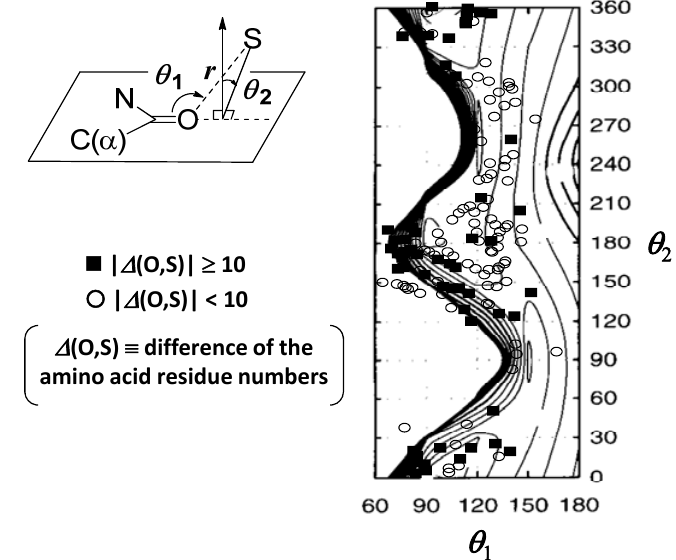
Figure 6. The directionality around the O atom in the S–S···O=C interactions in proteins superimposed on the potential surface calculated for the complex of between CH and CH CONHCH at MP2/6-31G(d). The contour lines are drawn with an interval of 3 3 0.25 kcal/mol. This figure was modified from reference [18].